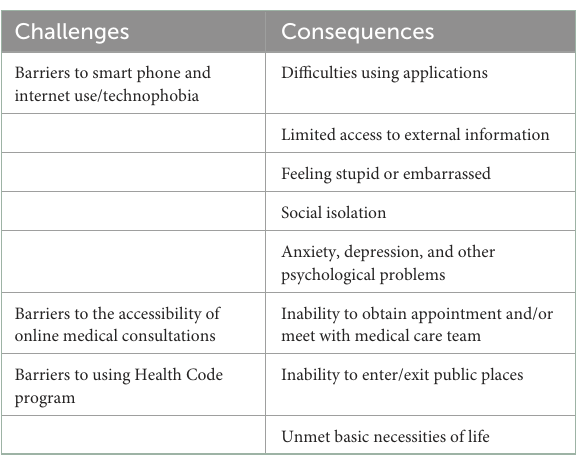
TABLE 2 Interview themes: Technology challenges and